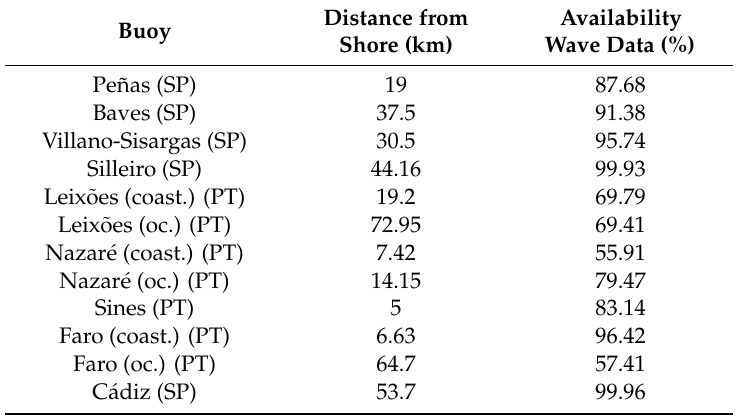
Table 1. Distance from shore and availability of buoy observations during a study time window (36 months). PT, Portuguese buoy; SP, spanish